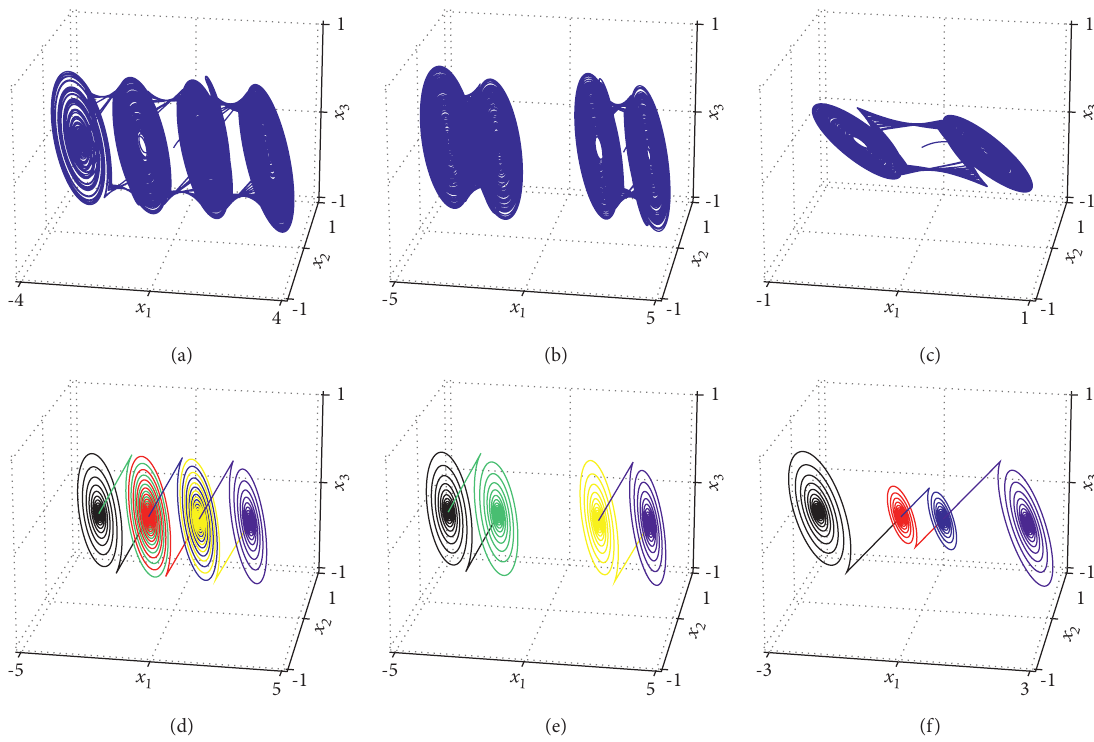
Figure 4: Attractors and heteroclinic orbits of the system are given by (1), (3), (5), (13), and (15) for α � 1 and different values of c . For c � 2 the system is exhibited in (a) a quad-scroll attractor, and in (d) six heteroclinic orbits. For c � 3 the system is exhibited in (b) two double- scroll attractors, and in (e) four heteroclinic orbits. For c � 1 . 5 the system is exhibited in (c) a double-scroll attractor and in (f) four heteroclinic